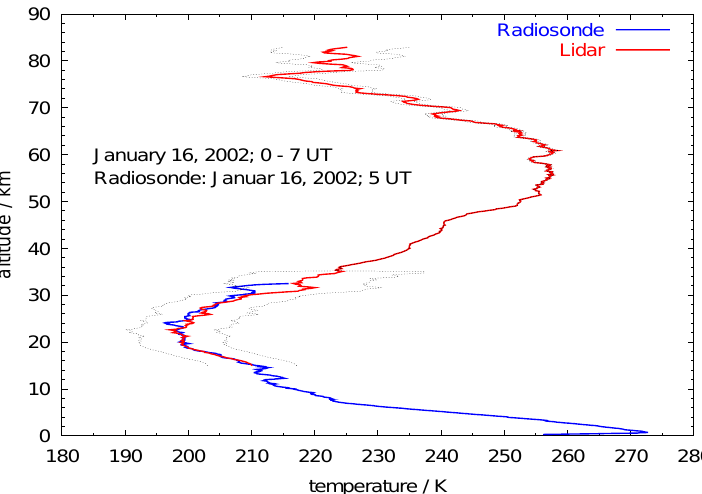
Fig. 8. Temperature profile and error measured by the U. Bonn lidar on 16 January 2002. The data cover an integration time of six hours in the time range from 0:00 UT–07:00 UT. Furthermore, a temperature profile measured by the radiosonde launched on 16 Januar 2002 at 05:00 UT at the Esrange is plotted. The increase of the temperature error at about 35km altitude is due to the change in the lidar channel.